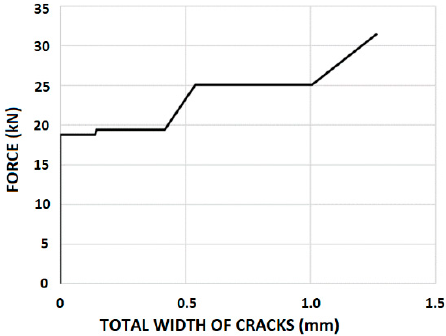
Figure 7. Total cracks width.